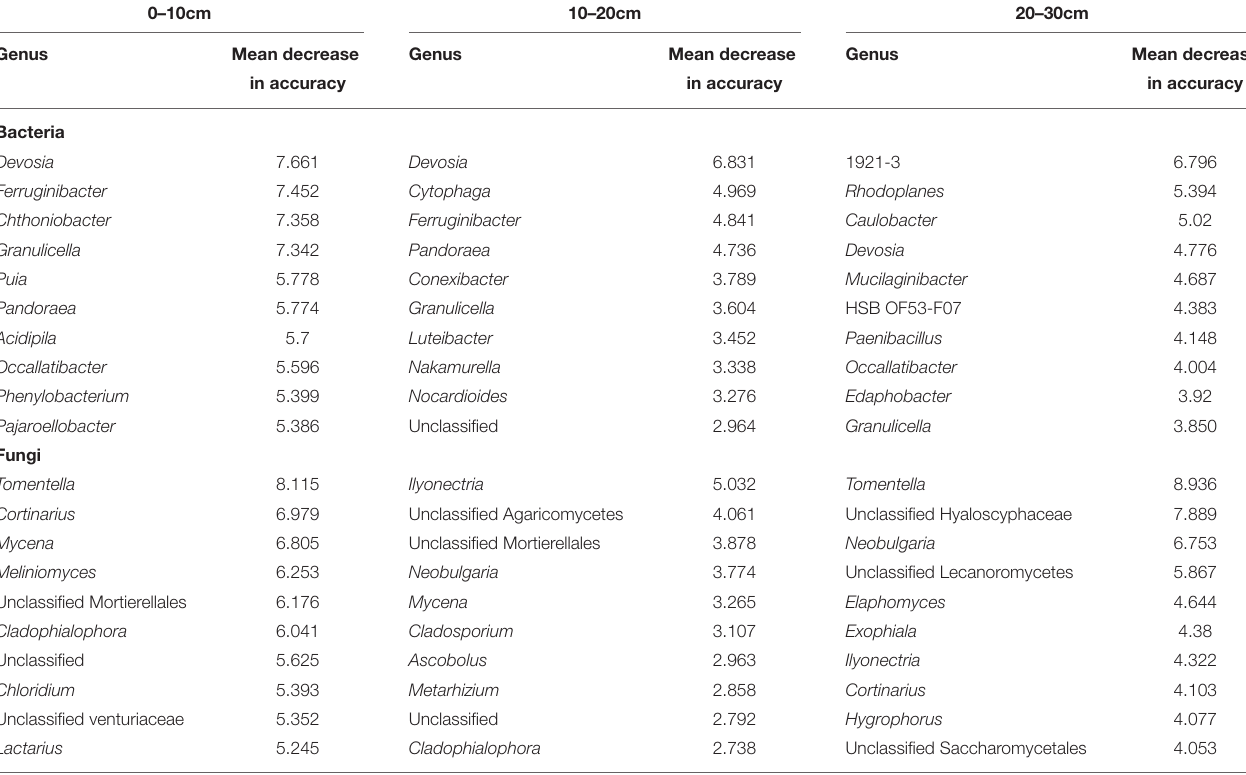
TABLE 2 | Top 10 bacterial and fungal genera associated with soil depth based on our RF